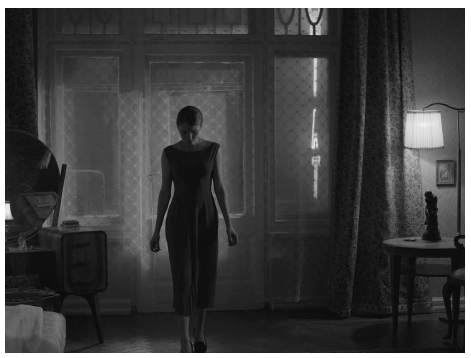
Religions 2016 , 7 , 72